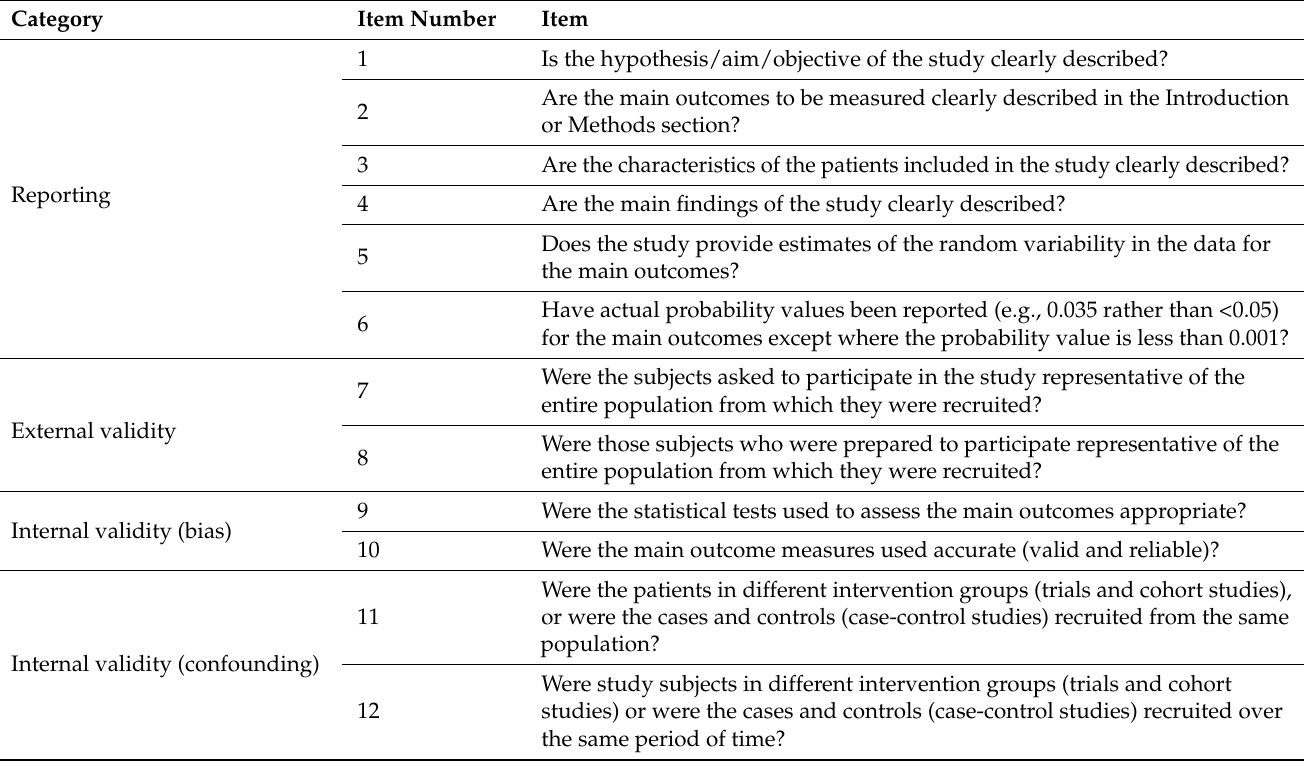
Table 1. Adapted Quality Index